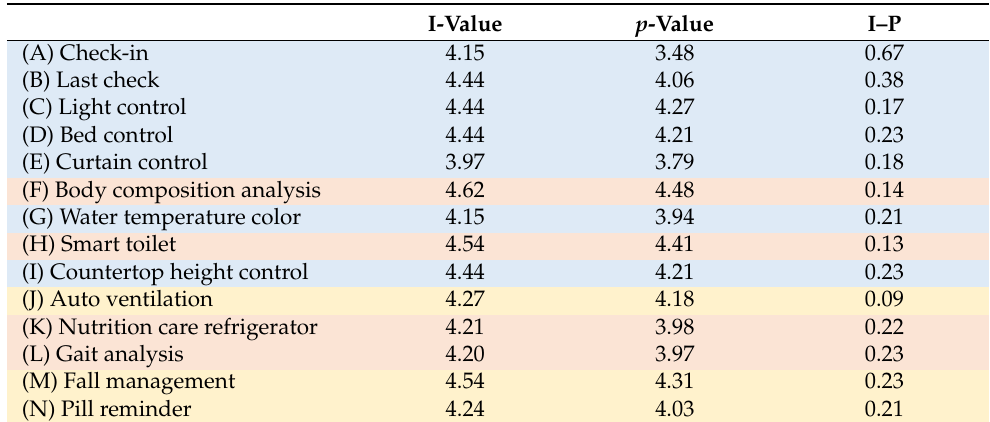
Table 6. Statistics